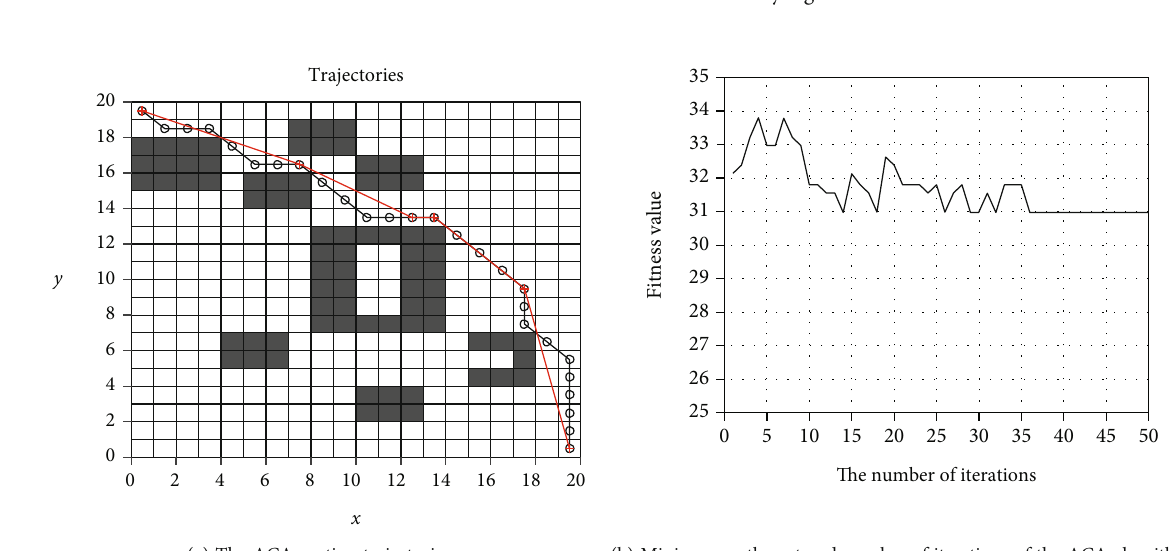
Figure 5: Ant potential fi eld mixing